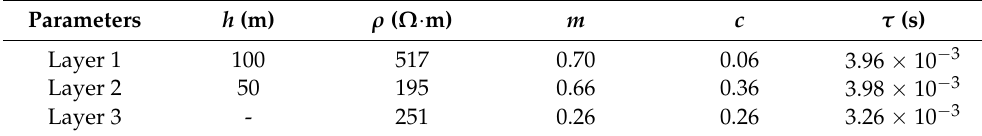
Figure 4. An example of TEM survey using the fixed-loop configuration.